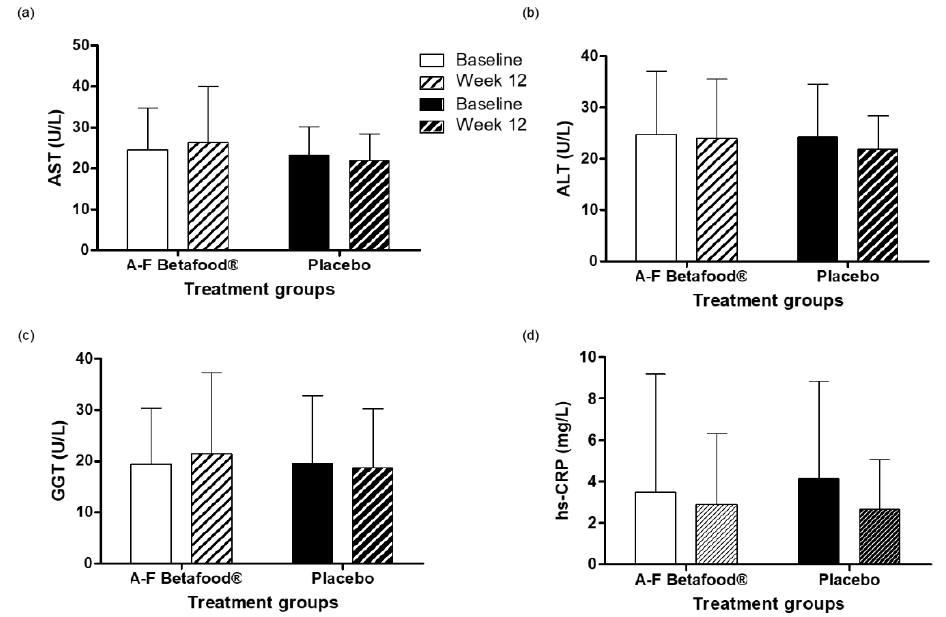
Figure 5. Liver function and inflammatory markers in the per protocol population at baseline and week 12 post-supplementation with A-F Betafood ® or placebo ( n = 42). ( a ) AST, ( b ) ALT, ( c ) GGT and ( d ) hs-CRP. Mean ± SD. AST, aspartate aminotransferase; ALT, alanine aminotransferase; GGT, gamma-glutamyltransferase; hs-CRP, high-sensitivity C-reactive protein.